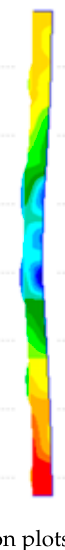
Figure 16. Load–deflection curves (locally rotationally constrained).